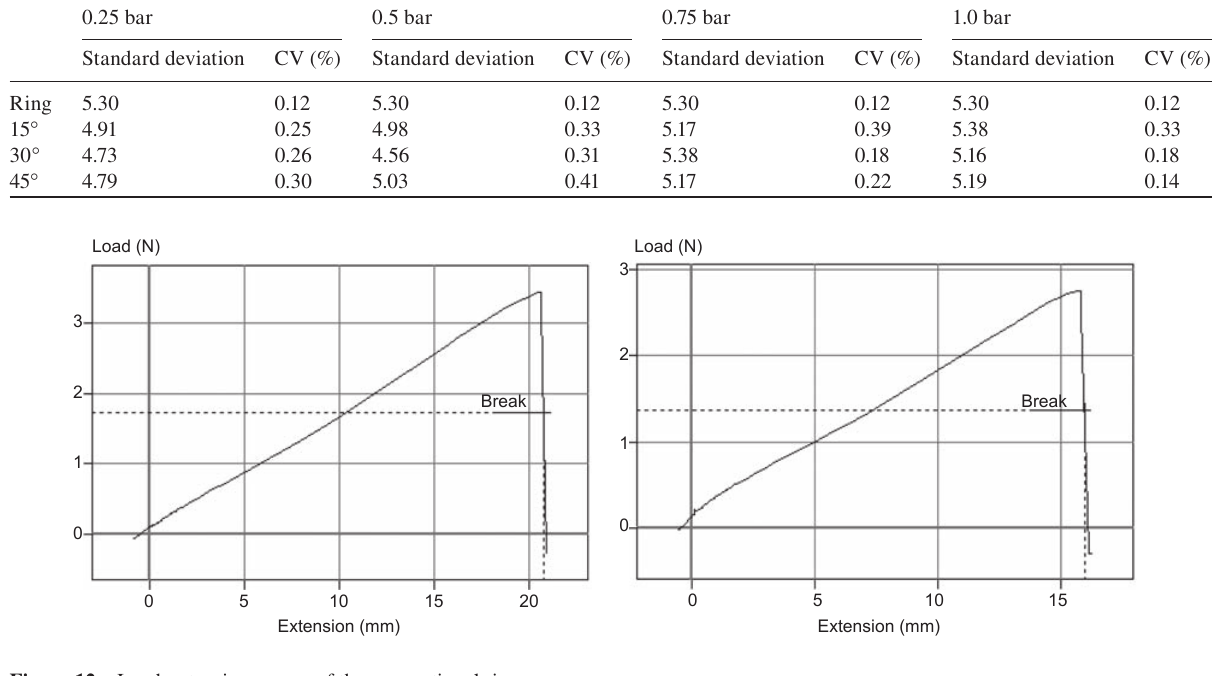
Table 11 Standard deviation and coeffi cient of variation values of elongation test